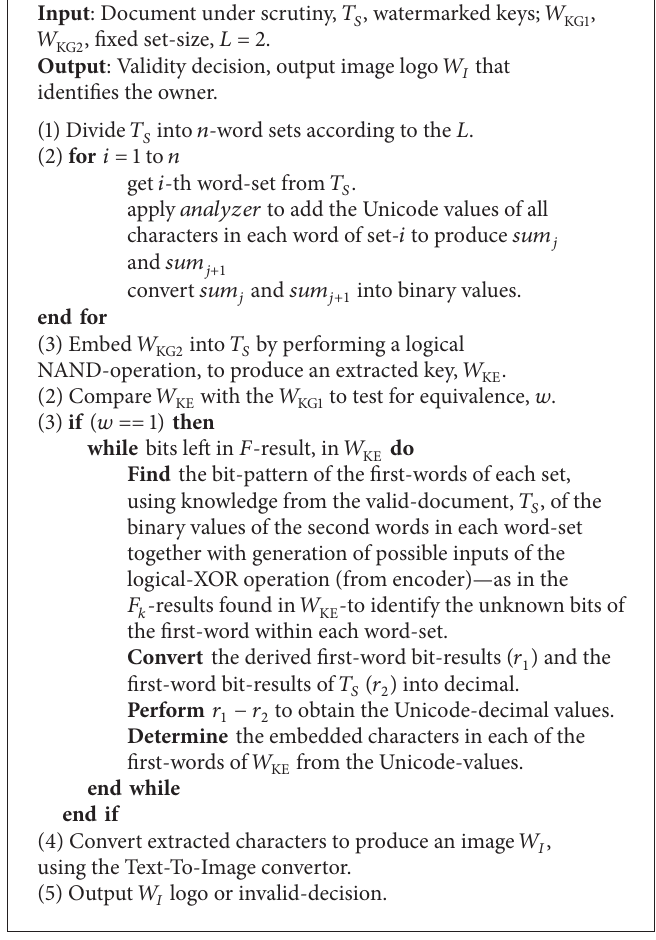
Algorithm 2: Decoding